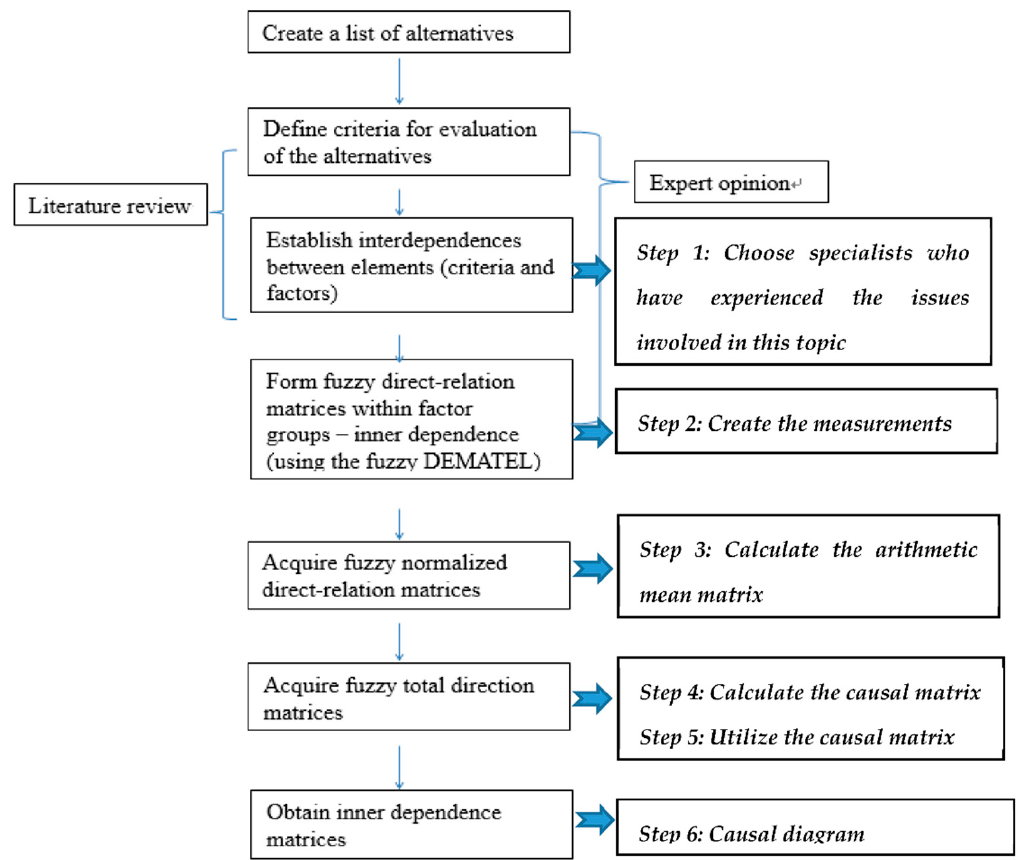
Figure 1. The structure and method of the DEMATEL. Source: Sun